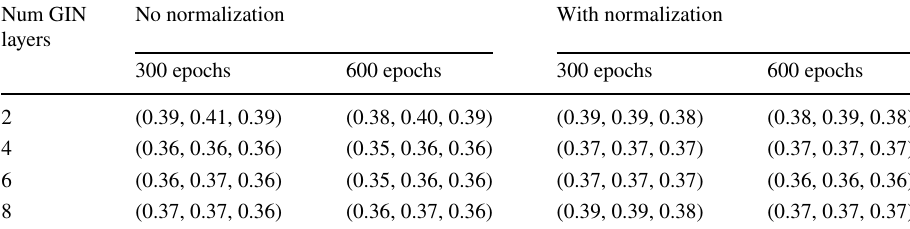
Table 2 Experimental results for accepted nodes computation with our 2GNN